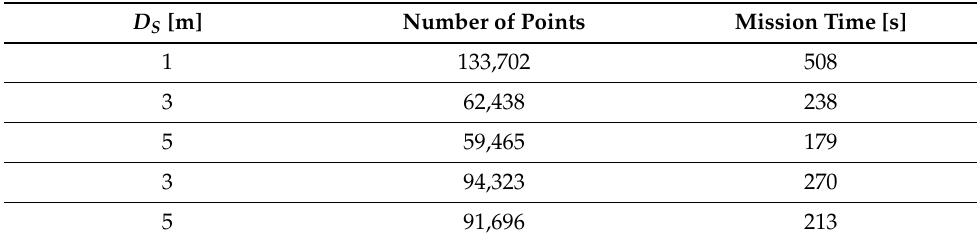
Table 3. Comparison between the variation of D S and its impact on the amount of points of 3D Reconstruction and the Mission Time.